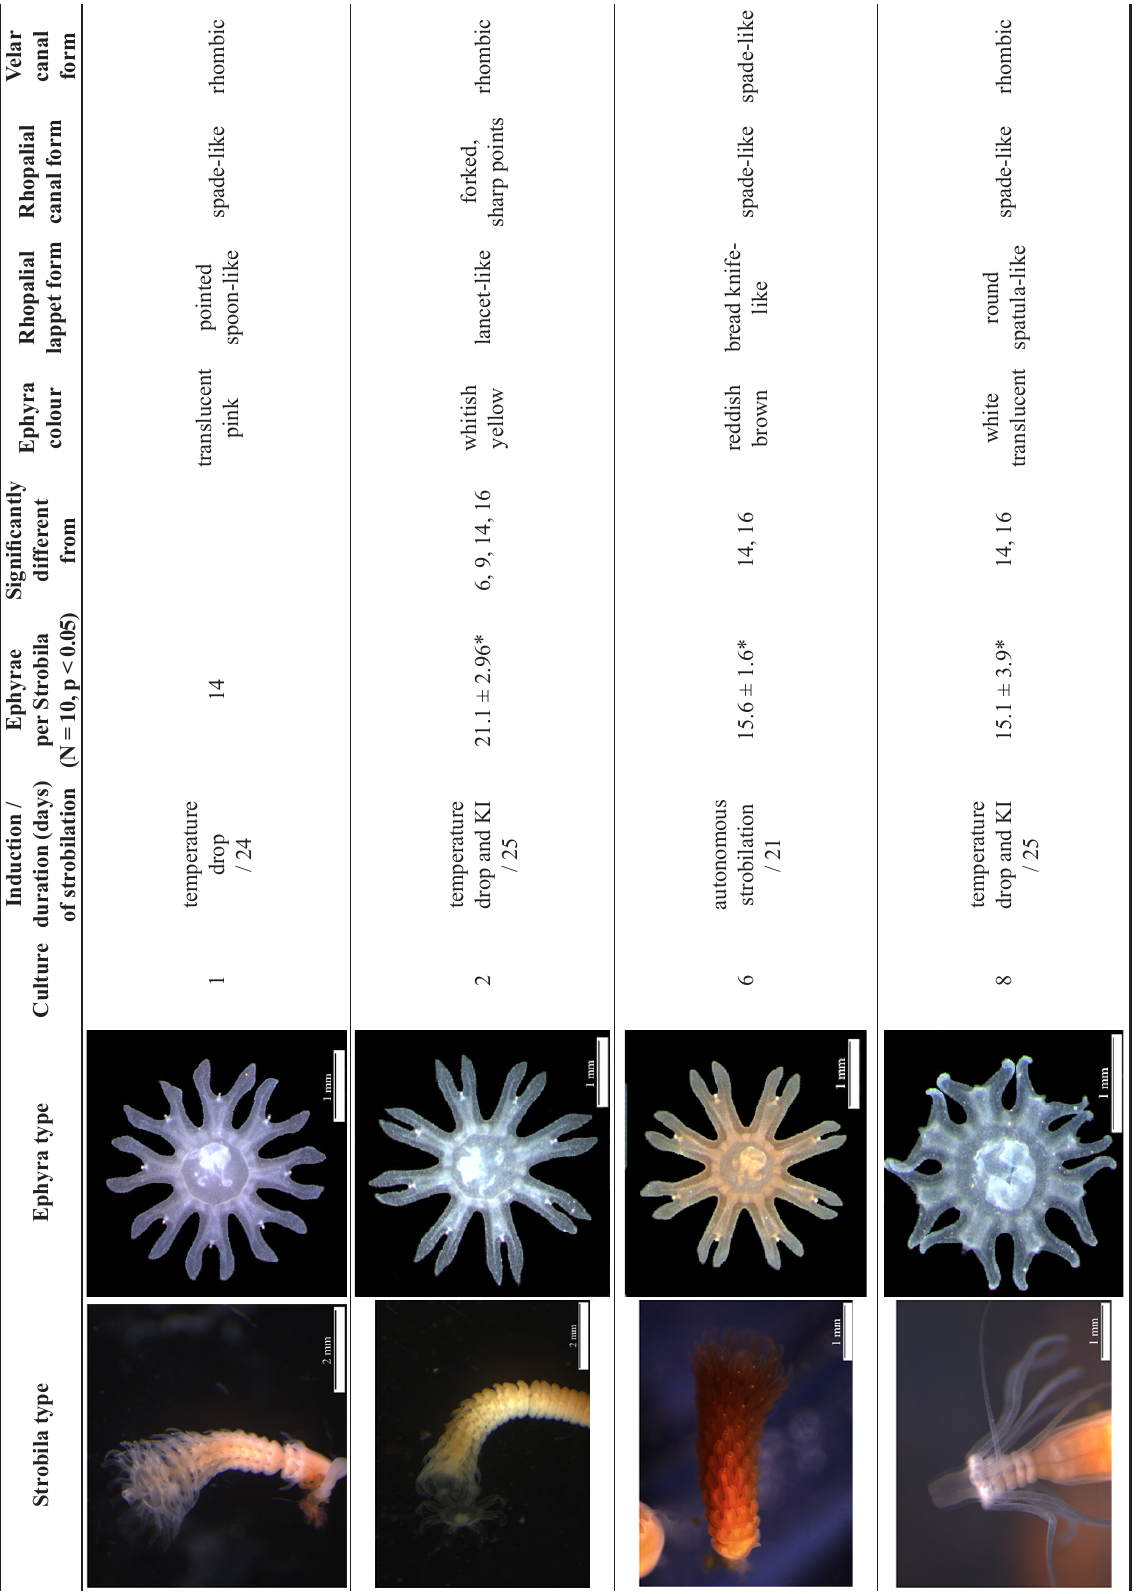
Table 5. Collected morphological features of the ephyrae of Aurelia